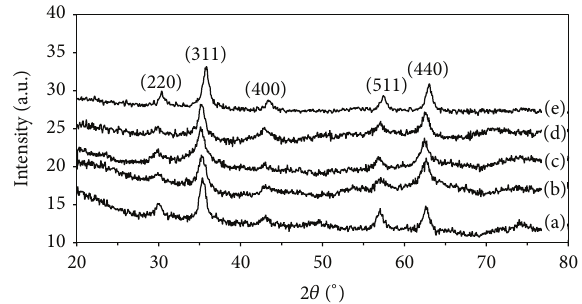
Figure 1: XRD patterns of maghemite nanoparticles for samples: (a) MNA2, (b) MNA4, (c) MNA6, (d) MNA8, and (e)